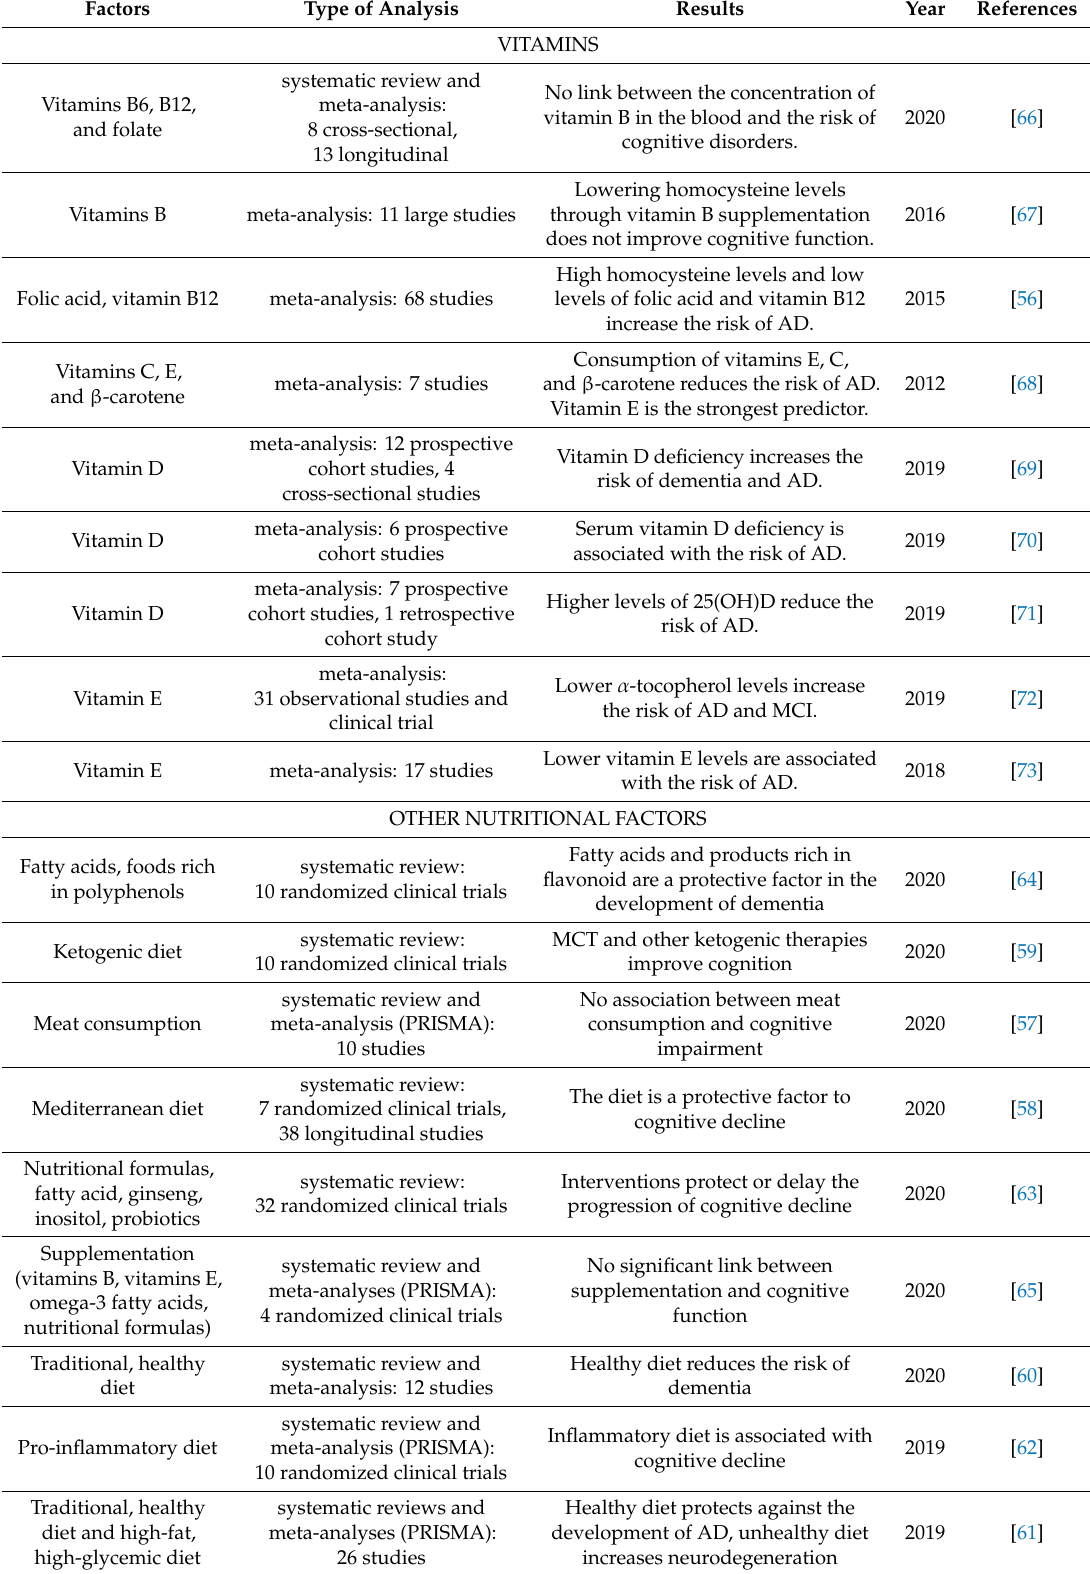
Table 6. A review of meta-analyses and systematic reviews of recent years on the e ff ects of nutrition on